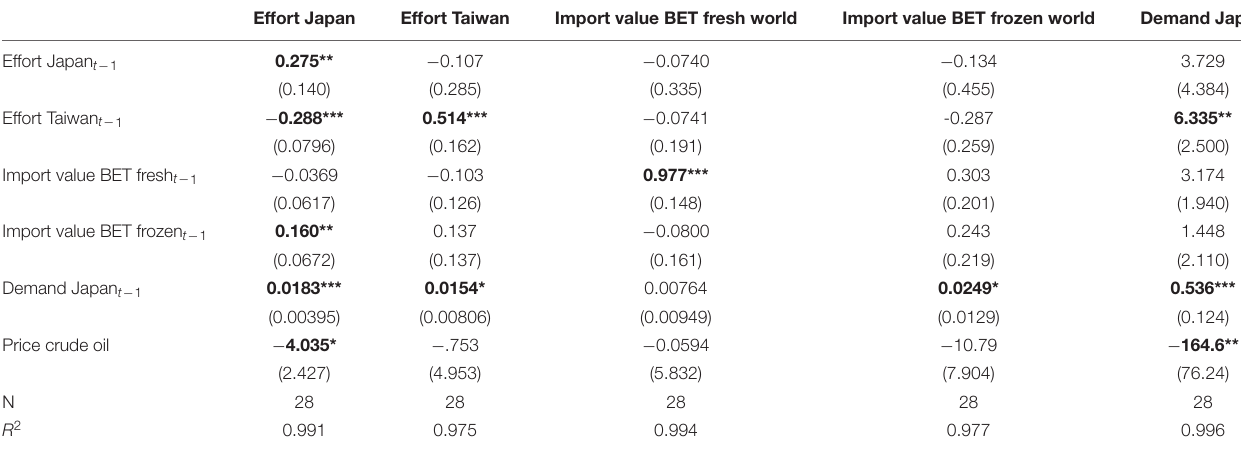
TABLE 3 | Results of a VAR estimation